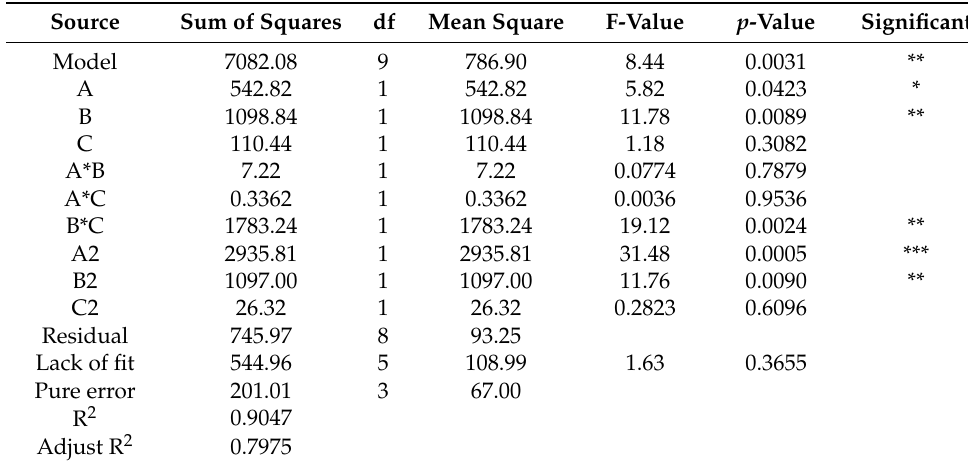
Table 4. The ANOVA results for the experimental model.